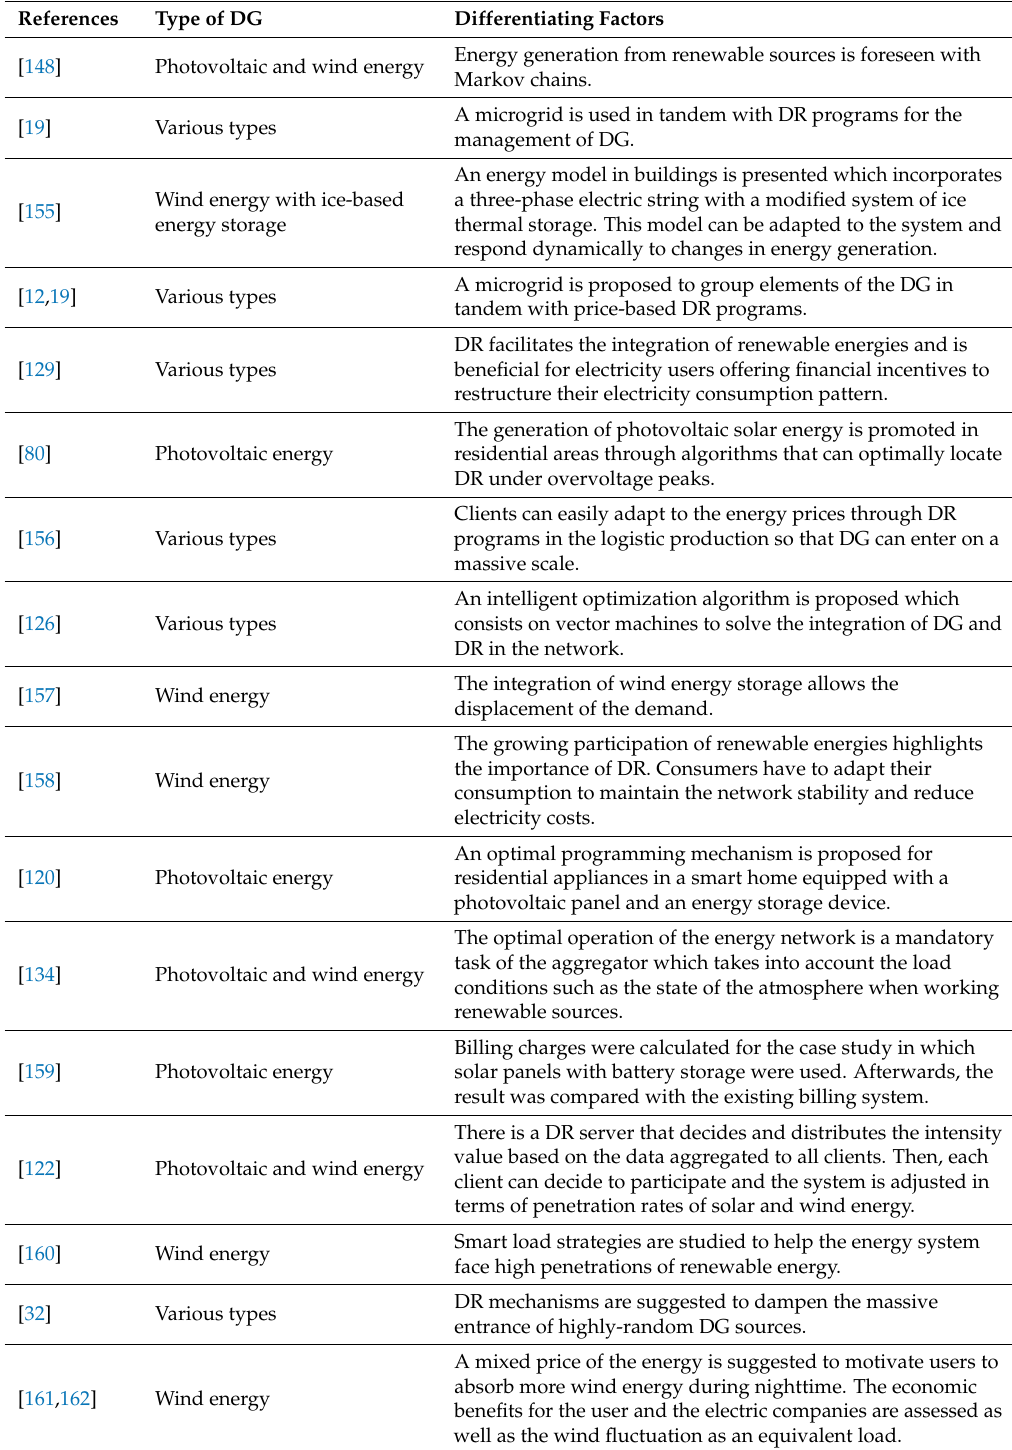
Table 8. DR programs and their connection to